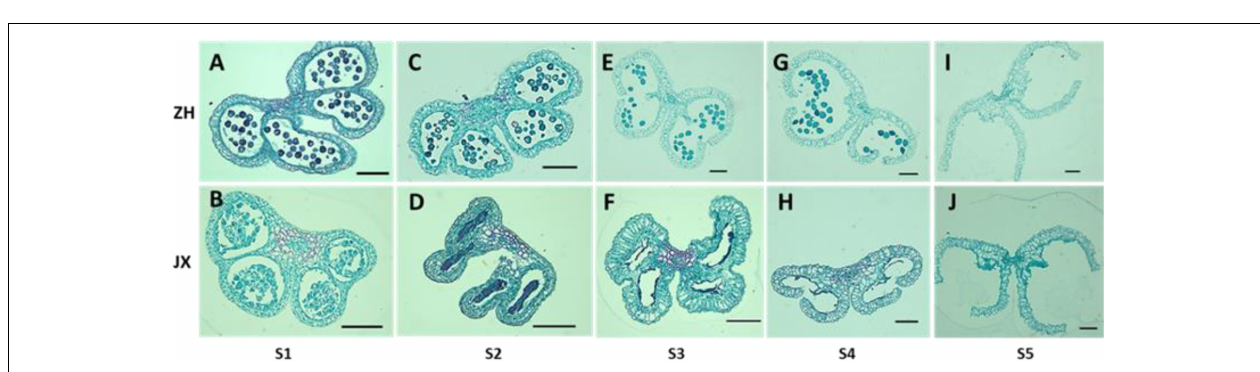
FIGURE 3 | Comparison of transverse section of anthers between “ZH” and “JX” at five development stages as described in Section “Materials and Methods.” All bars represent 100 µ m. (A,C,E,G,I) Transverse section of ‘ZH’ anthers. (B,D,F,H,J) Transverse section of ‘JX’ anthers.